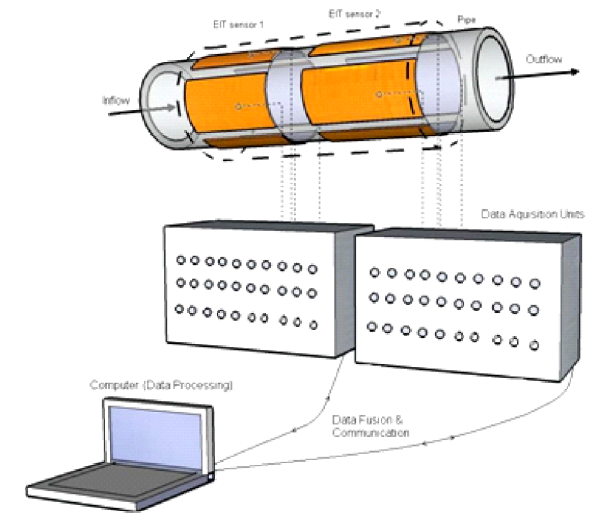
Figure 1: Sensor Data Fusion/ Soft Sensors involved in Process Tomography with multiple resistive and capacitive sensors serves simultaneously as an example of sensor networking when different protocols are used, in selecting the combinations of sensors and their automatic switching. Graphic by PhD student Yan